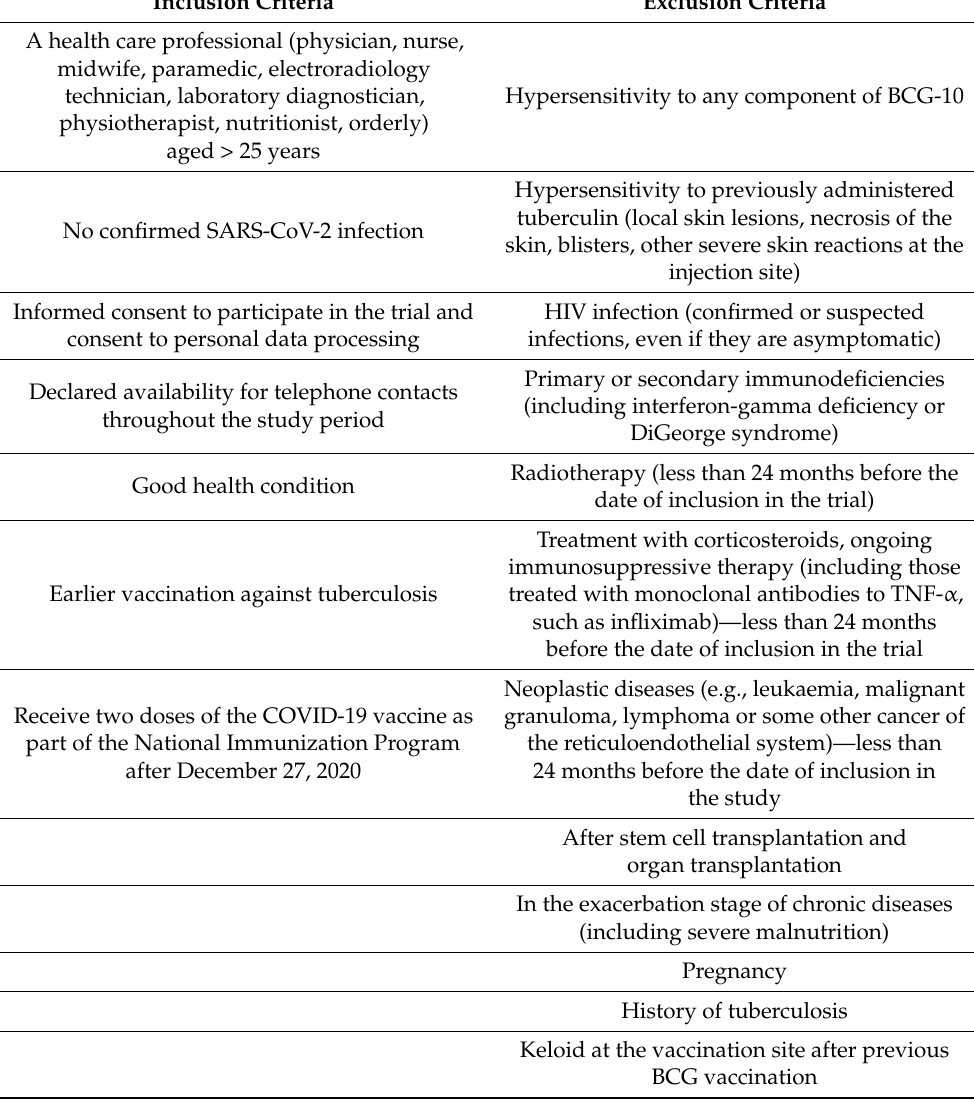
Table 1. The study inclusion and exclusion